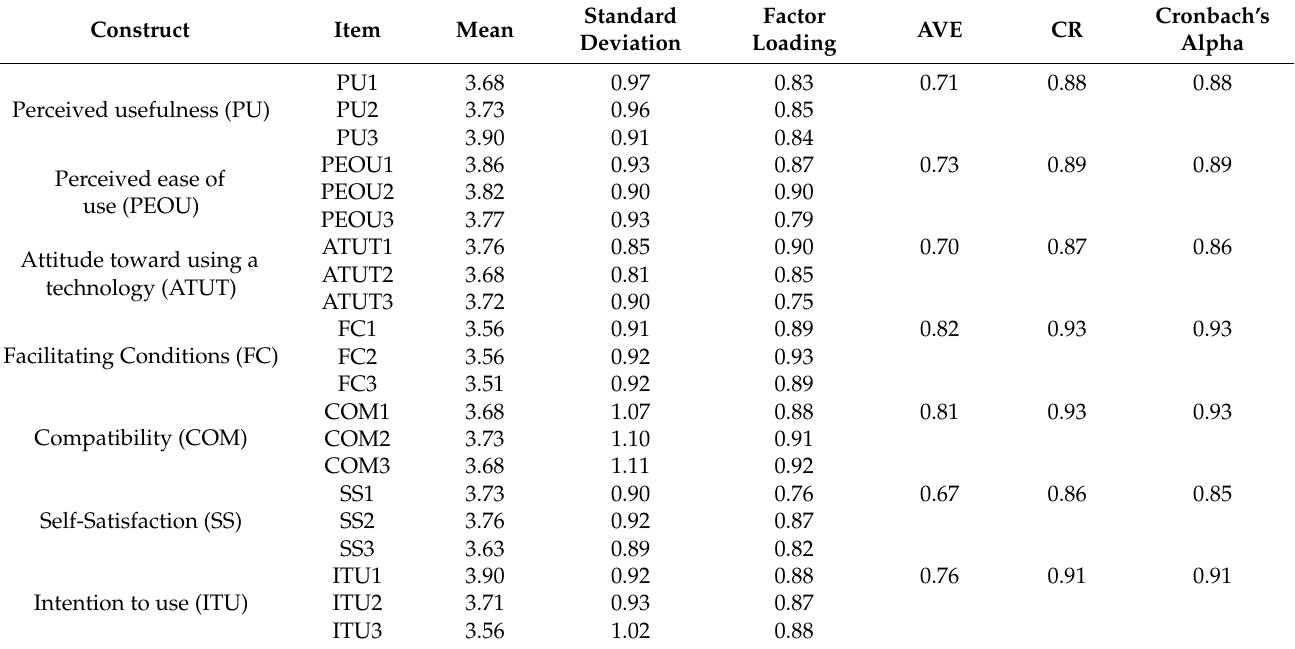
Table 4. Results for the convergent validity and reliability assessment of the measurements.